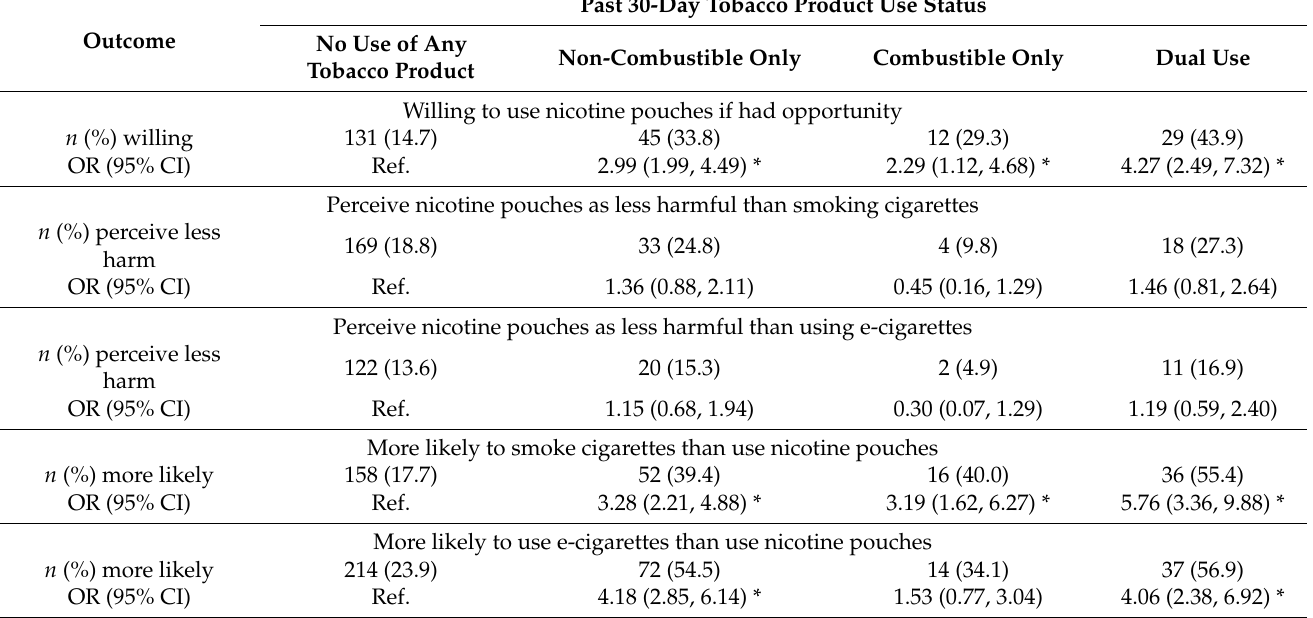
Table 3. Associations of past 30-day tobacco use status with nicotine pouch use willingness and